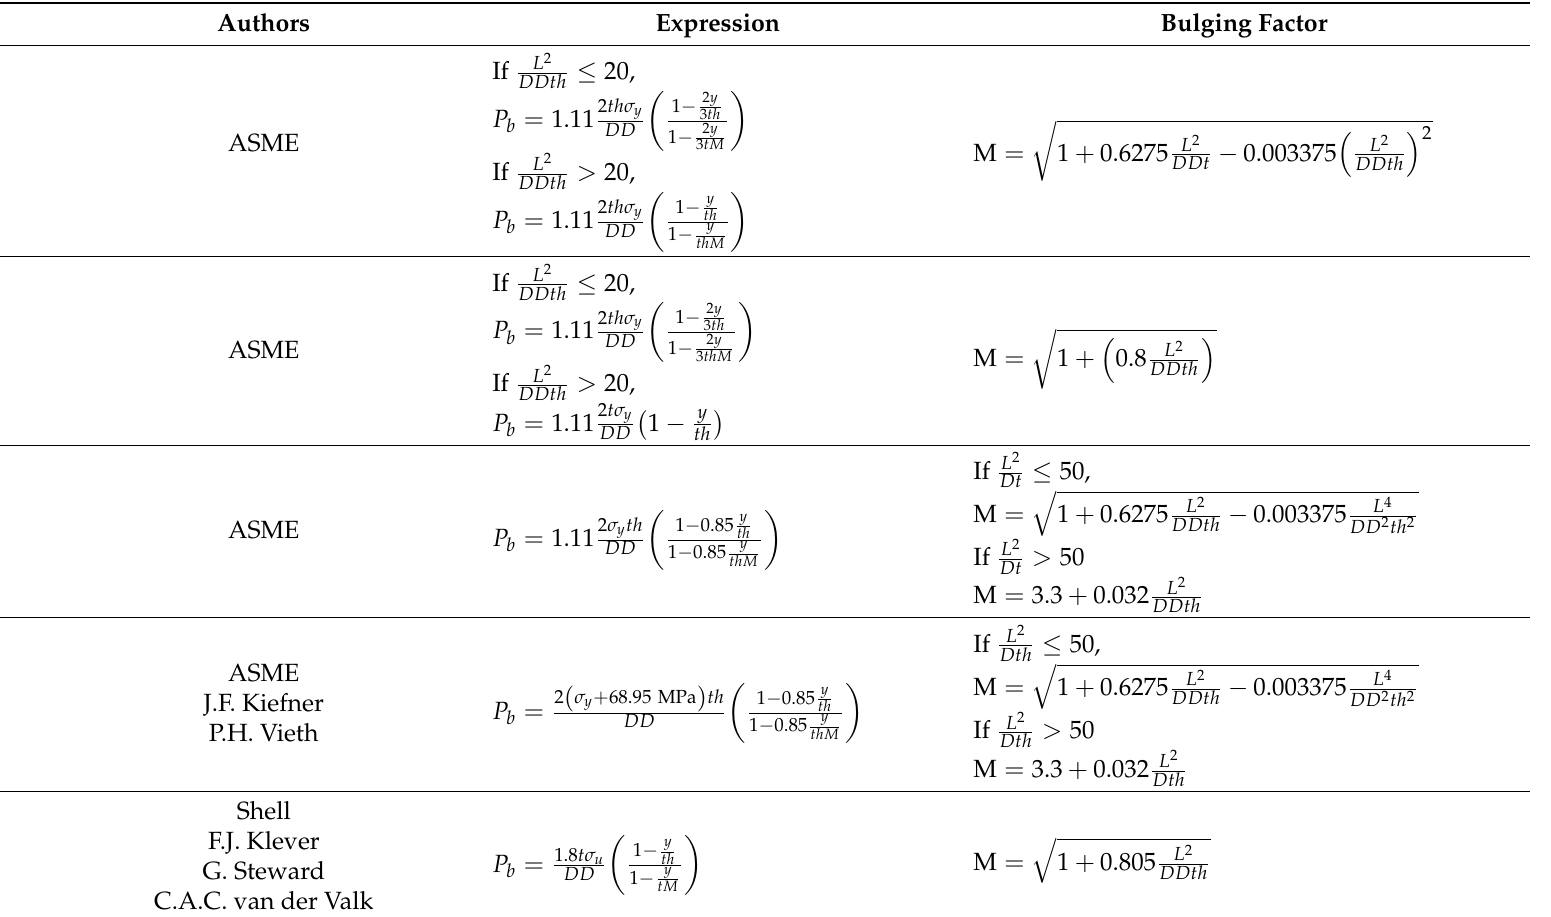
Table 2. Pipeline failure pressure